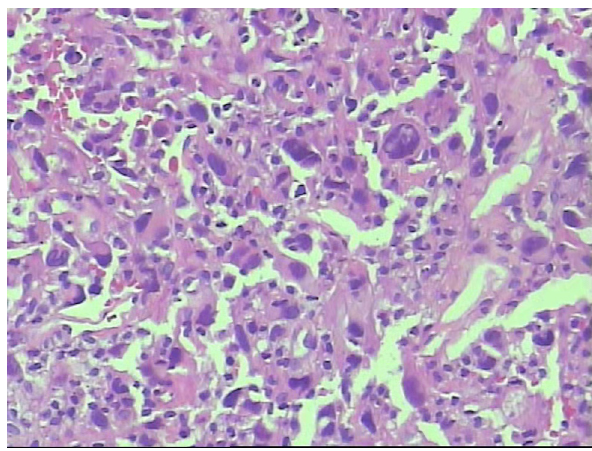
Figure 5: Histopathology of aortic tissues showed that the tumor was composed of malignant spindle cells and demonstrated nuclear pleomorphism and atypia ( hematoxylin and eosin staining × 200 )